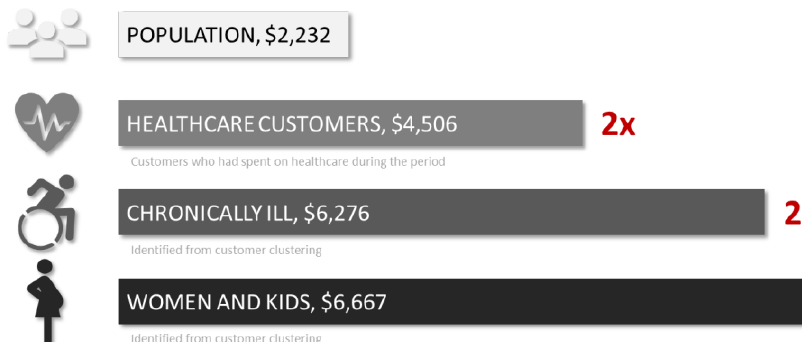
× to 3 × higher in average Figure 4. Healthcare customers made 2× to 3× higher in average spending. Figure 4. Healthcare customers made 2